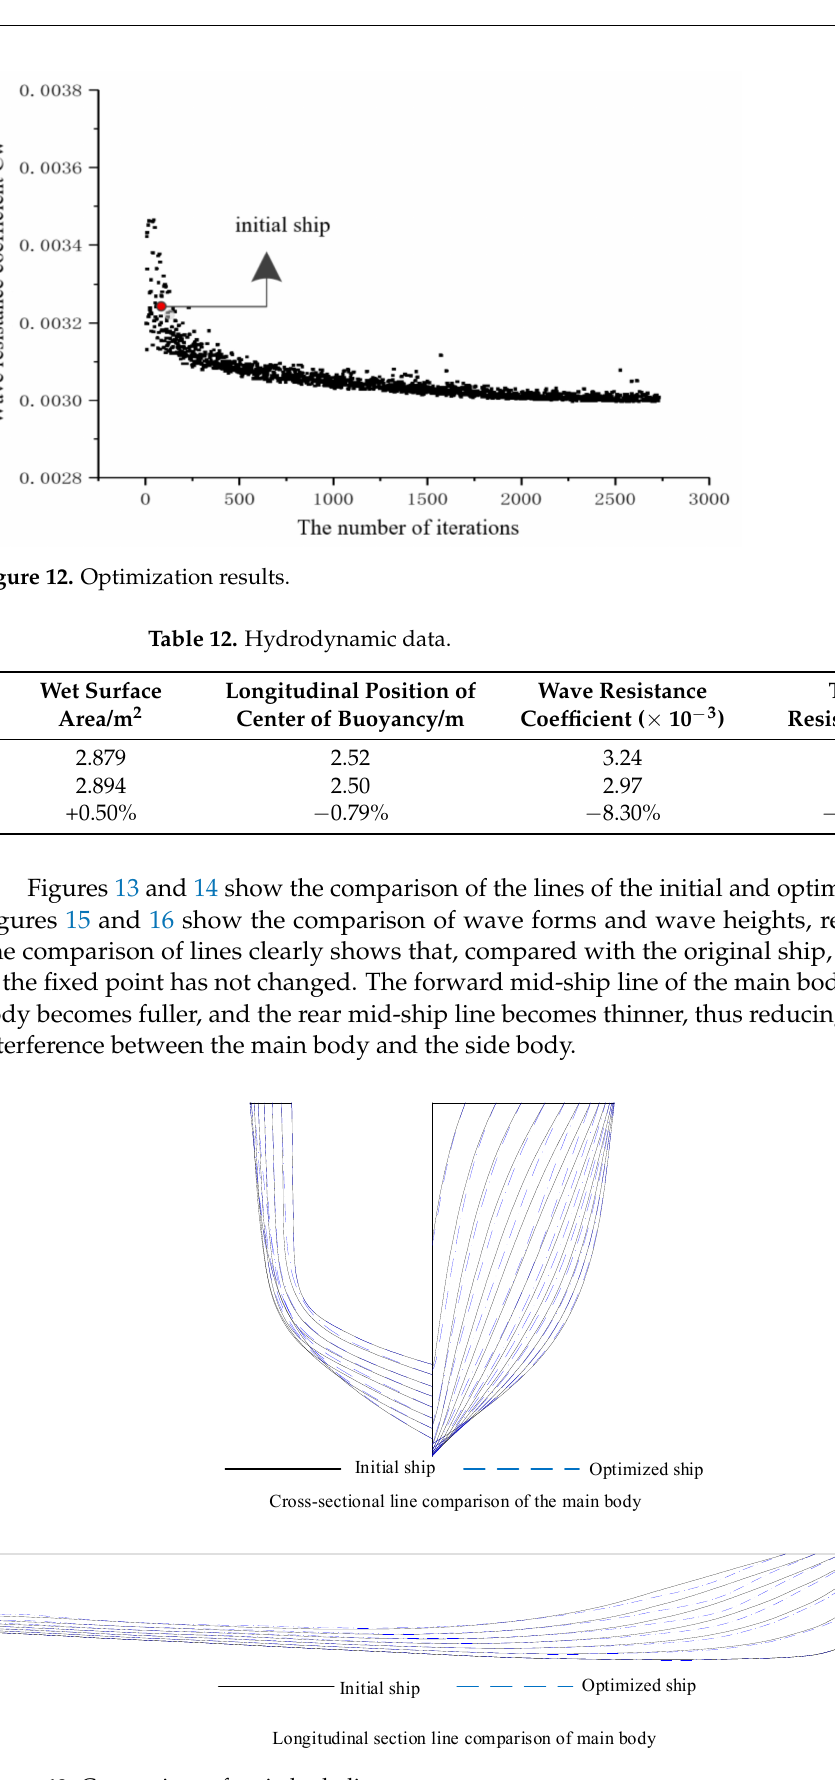
. Figure 14. Comparison of side body lines. 侧体纵剖线对比侧体横剖线对比初始船